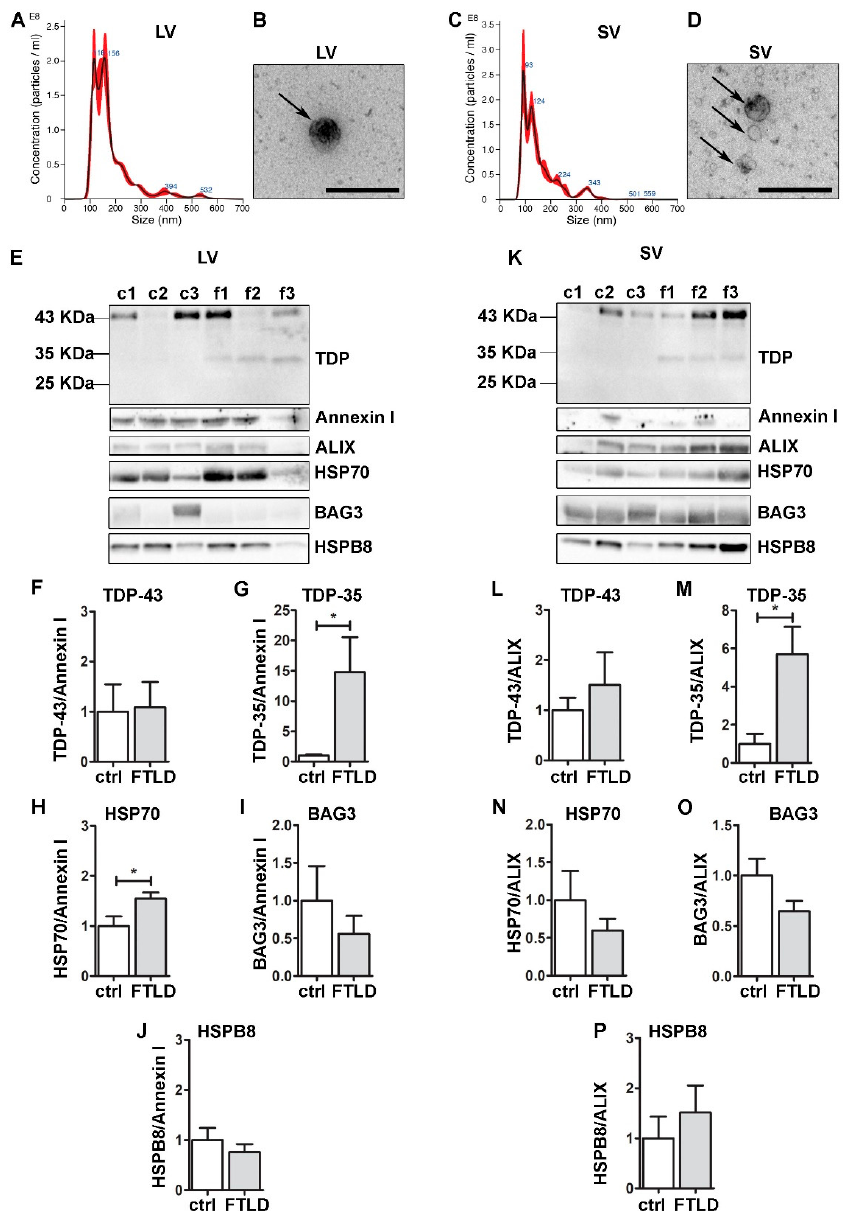
Figure 6. Plasma-derived EVs from FTLD patients are enriched in pathological TDP-35 and contain CASA complex components. Analysis of LVs and SVs from plasma of healthy controls and FTLD patients (n = 3). ( A and C ) Representative NTA analysis of LVs ( A ) and SVs ( C ) from plasma of a healthy control. x -axis = vesicles dimension, expressed in nm; y -axis = vesicles concentration, expressed as number of particles/mL. LV, mean size = 180.2± 3.9 nm; SV, mean size = 154.1± 1.7 nm. ( B and D ) Representative TEM images of LVs (one LV of approximately 200 nm) and SVs (three SVs of approximately 100–150 nm) from plasma of a healthy control (Scale bar: 500 nm). ( E – K ) WB and relative quantifications of LVs ( F–J ) and SVs ( L – P ) samples from plasma of three healthy controls (c1–c2–c3) and three FTLD (f1–f2–f3) patients. Samples were analyzed for TDP-43 species, Annexin I, ALIX, HSP70, BAG3 and HSPB8. Bar graphs represent the mean optical density ± SD of a specific protein normalized on the optical density of the internal housekeeping protein (annexin I for LVs and ALIX for SVs) and reported as relative to control (ctrl) group, for three biological replicates. (* p < 0.05, unpaired one-tailed t